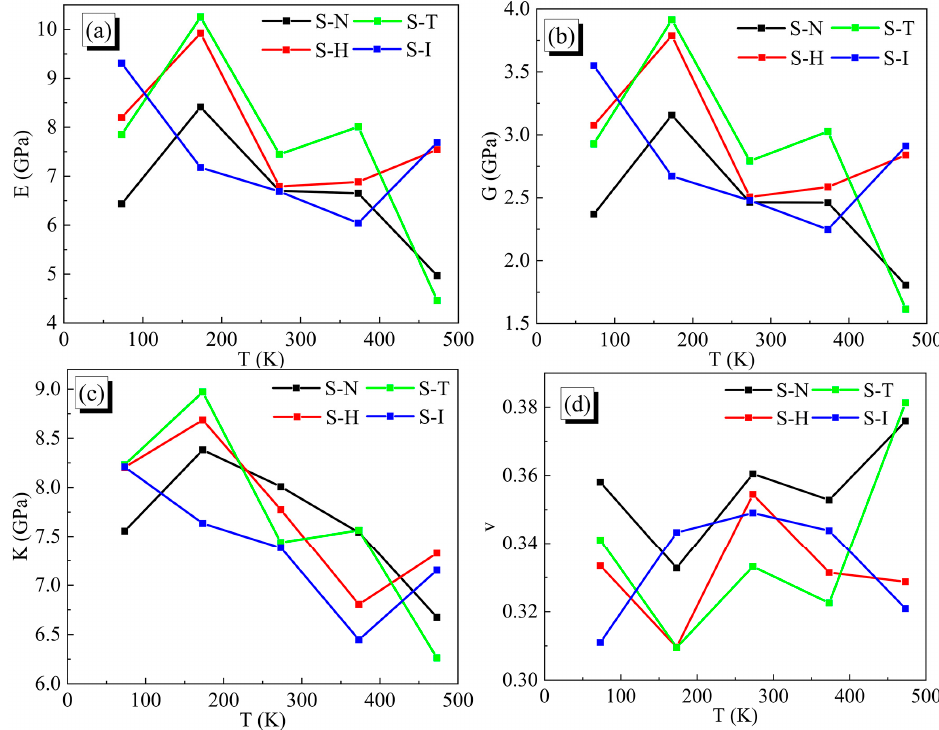
Figure 7. Mechanical properties of IPN binder models at 73.15 K, 173.15 K, 273.15 K, 373.15 K and 473.15 K. ( a ) Young’s modulus, ( b ) Shear modulus, ( c ) Bulk modulus and ( d ) Poisson’s ratio.